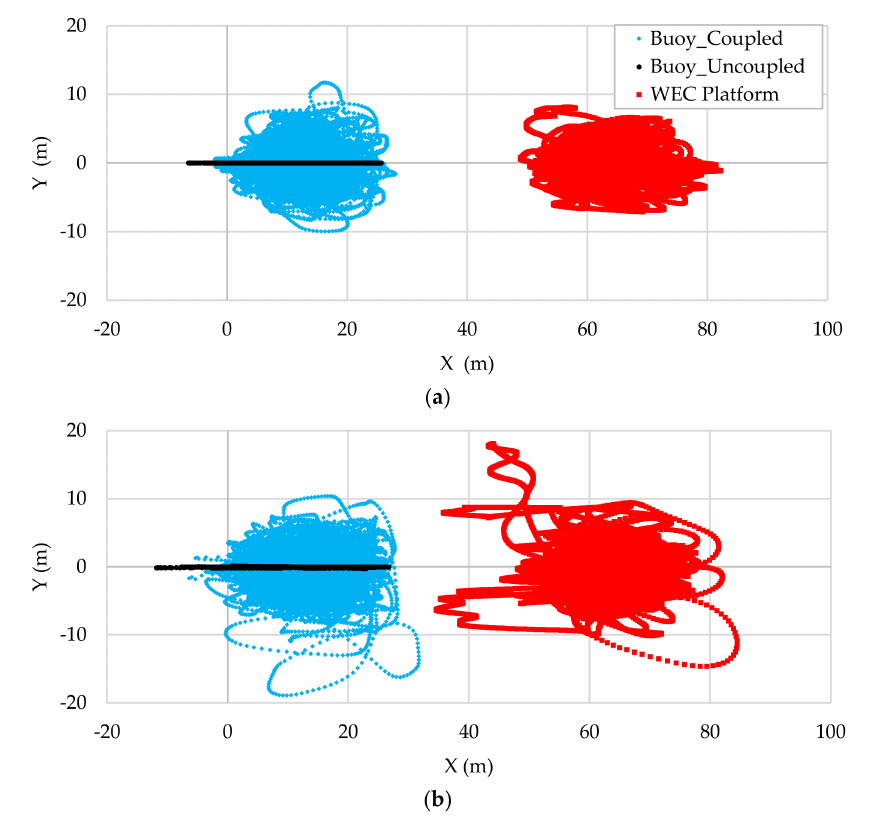
Figure 10. Watch circles of mooring buoy and WEC platform under heading 0 deg.: ( a ) 50 y; ( b ) 100